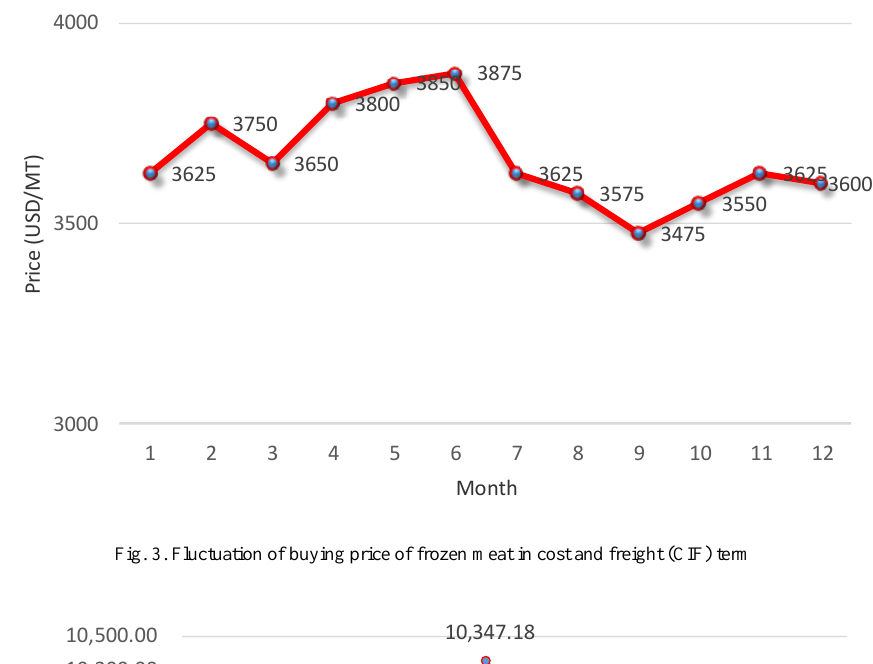
Fig. 3. Fluctuation of buying price of frozen meat in cost and freight (CIF) term